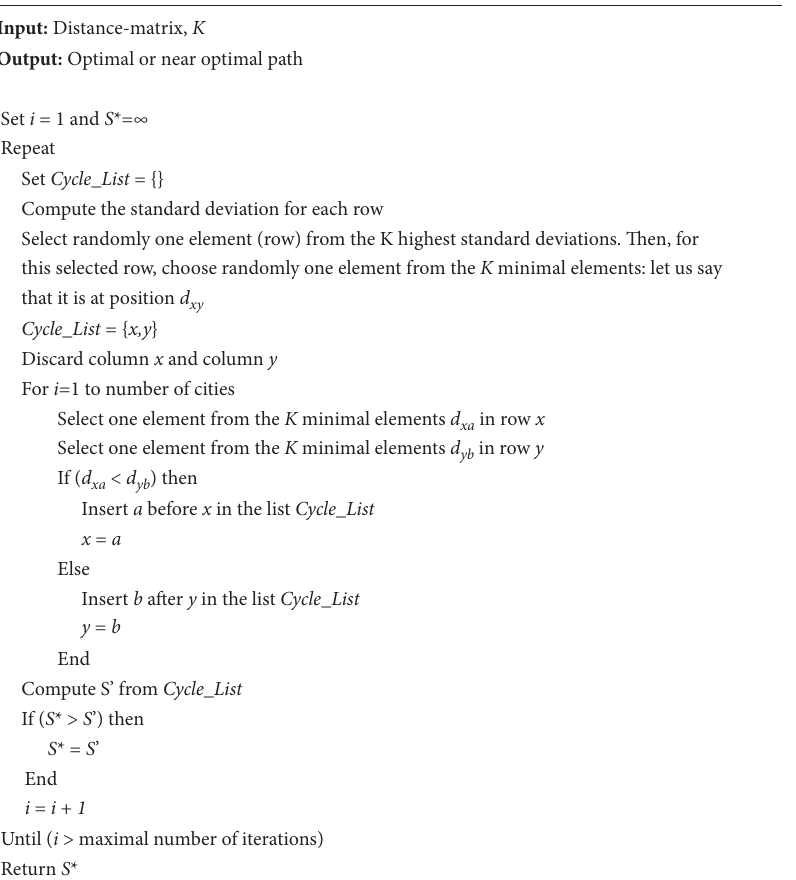
Figure 3: The general body of the DM-TSP2 algorithm.